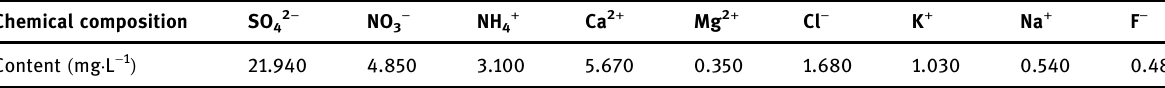
Chemical composition